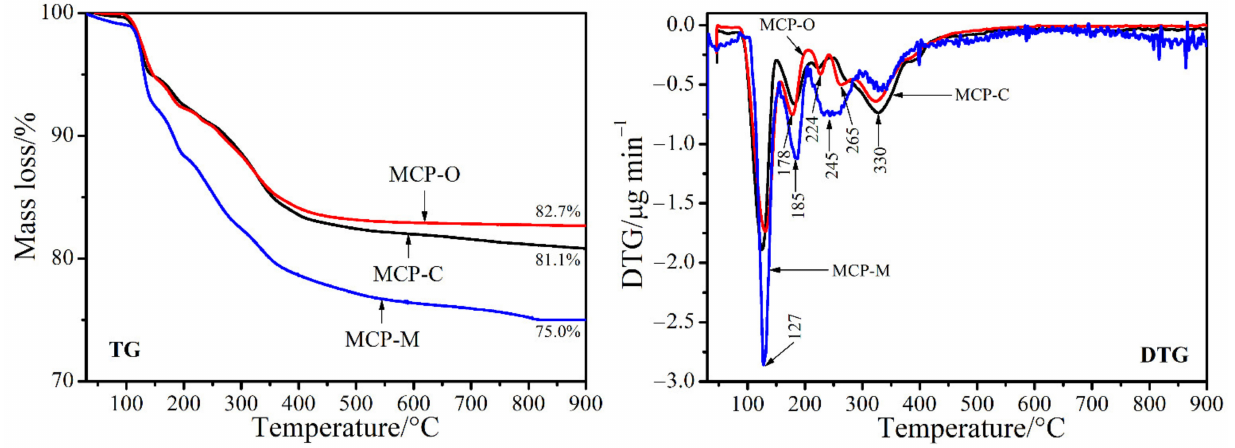
Figure 6. TG and DTG curves of MCP-C, MCP-M, and MCP-O samples. The final decomposition of Ca(H 2 PO 4 ) 2 · H 2 O to calcium polyphosphate Ca 3 (PO 3 ) 2 ,